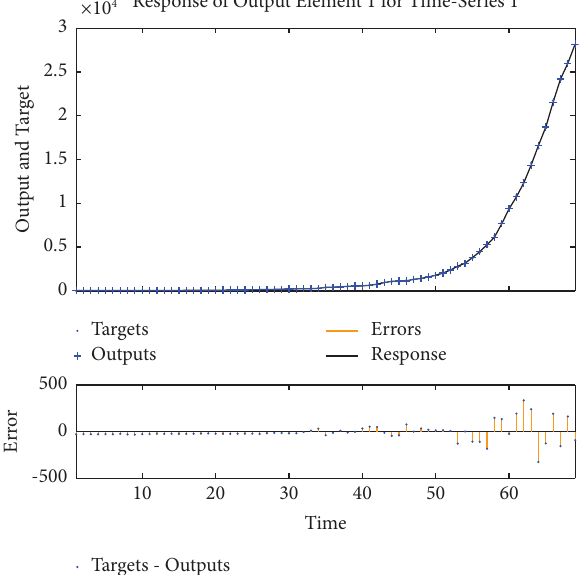
Figure 3: Te error between the predicted national vehicle ownership data and the actual data.